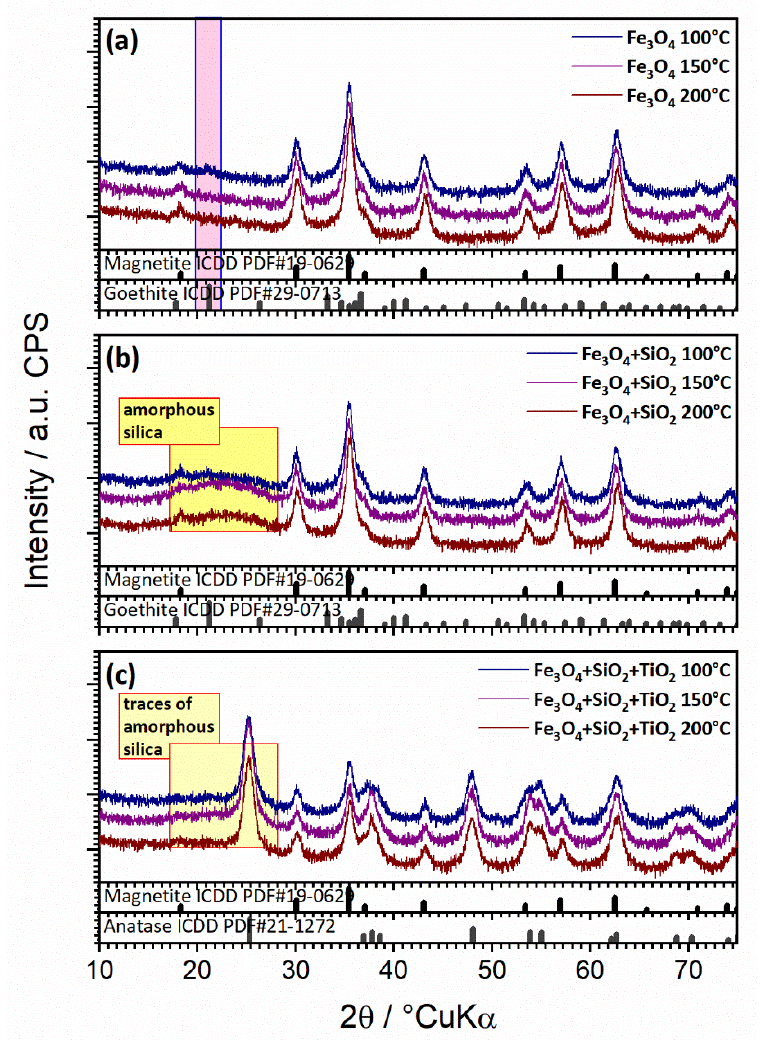
Figure 2. Diffractograms of Fe 3 O 4 ( a ), Fe 3 O 4 /SiO 2 ( b ), and Fe 3 O 4 /SiO 2 /TiO 2 ( c ) samples synthesized by the microwave-assisted method at 100 °C (blue line), 150 °C (violet line), and 200 °C (brown line).